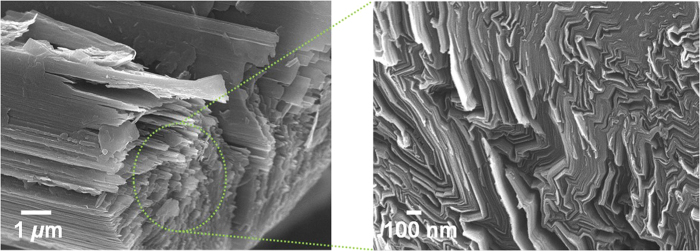
SEM images of weakly exfoliated p-CF (after immersing p-CF in H2SO4/HNO3 (3:1) for 32 hrs at r. t.).